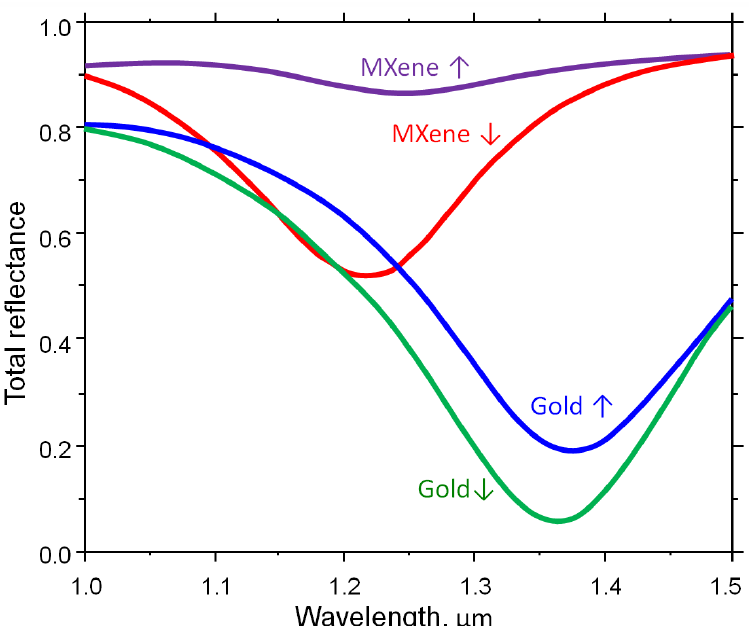
Figure 2. Spectral reflectance of the structure shown in Figure 1a; purple line: MXene coating, normal incidence from the bottom, TM polarization; red line: MXene coating, normal incidence from the top, TM polarization; blue line: gold coating, normal incidence from the bottom, TM polarization; and green line: gold coating, normal incidence from the top, TM polarization.